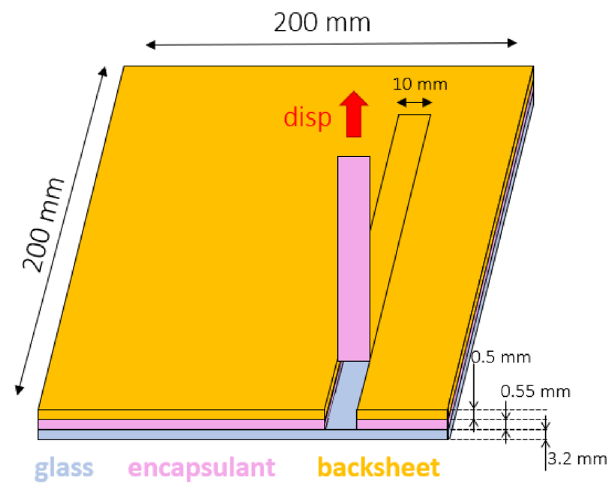
Fig. 7. Peeling test samples ’ architecture.